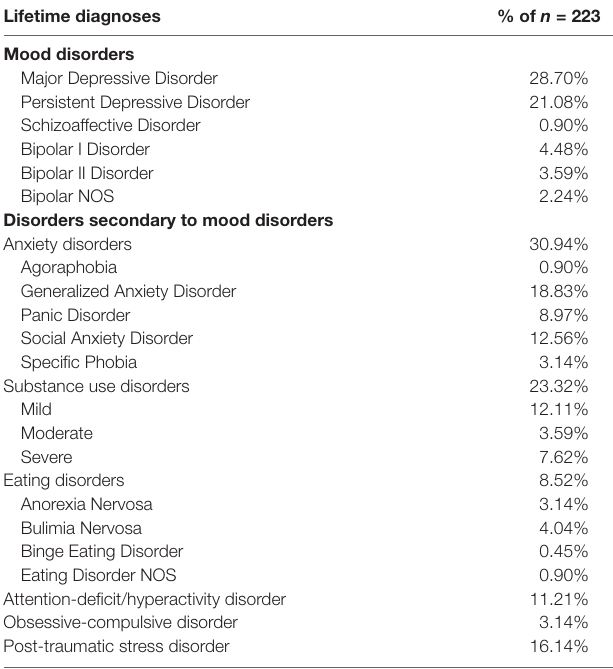
TABLE 2 | Lifetime diagnoses of participants in Study 2, which consisted of individuals with current mood disorders at the time of recruitment, or individuals with no history of psychopathology.